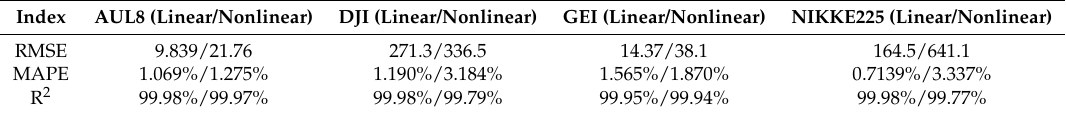
Table 3. Performances of different groups of four time